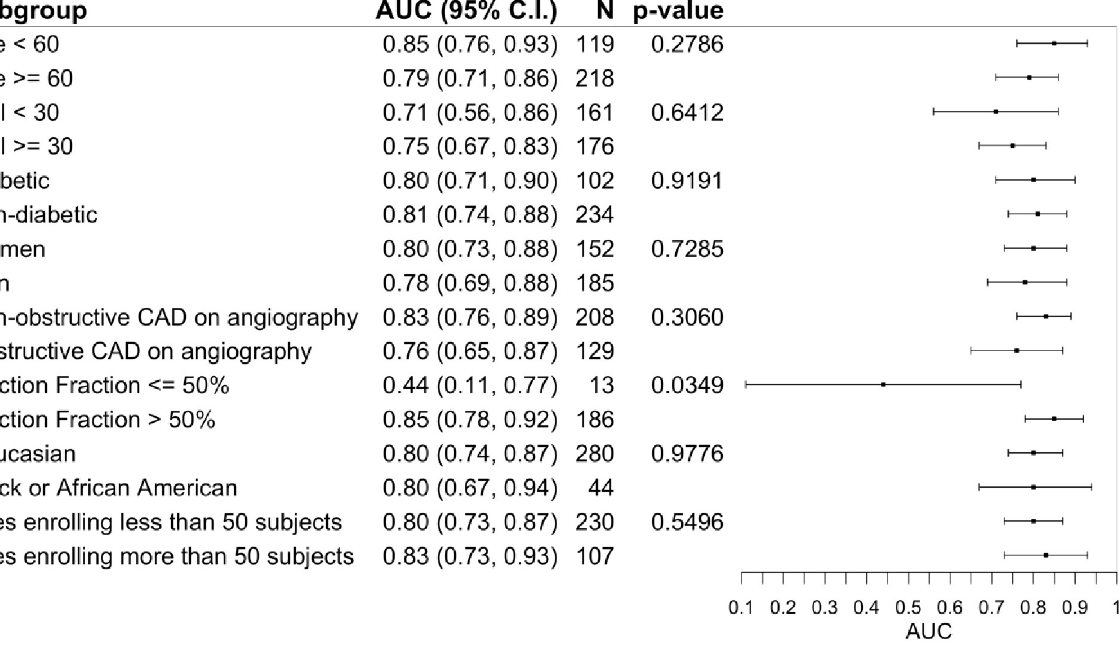
Fig 7. Subgroup analyses of the performance of the machine-learned